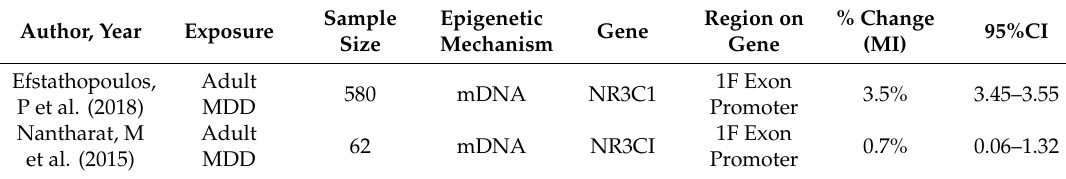
Table 3. DNA Methylation of NR3C1 in Major Depressive Disorder.